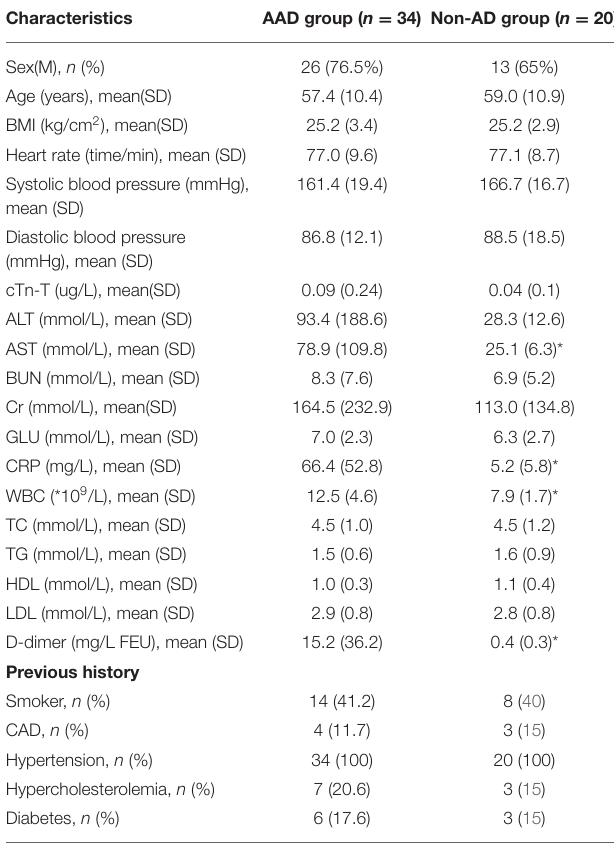
TABLE 1 | Clinical and biochemical characteristics in AAD and Non-AD groups.